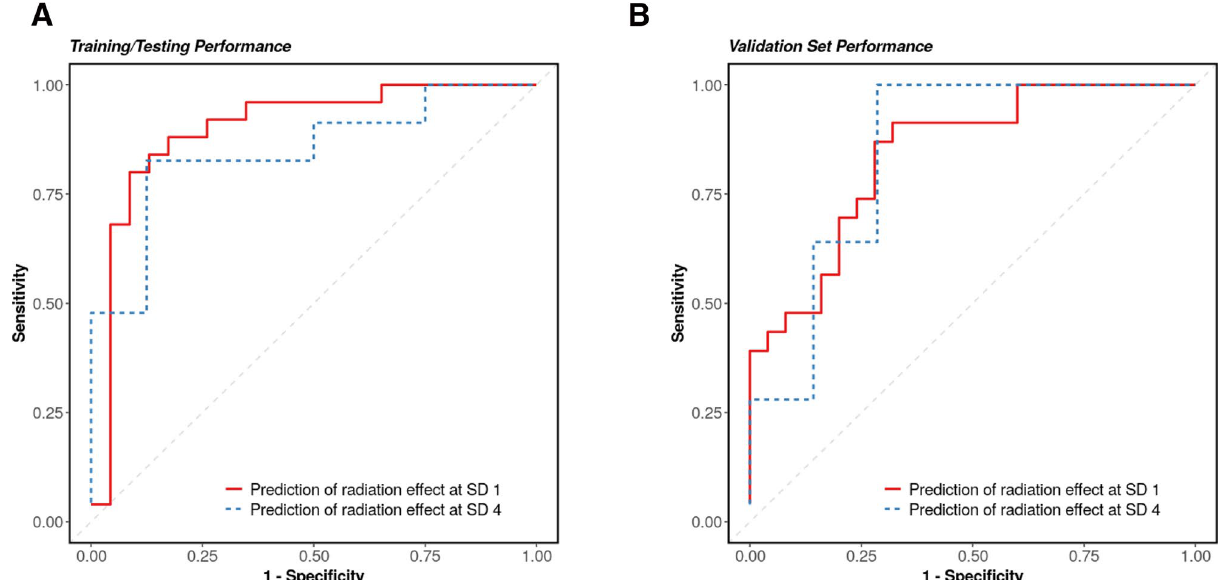
Figure 5. The biomarkers panel to distinguish whether NHP got radiation or not in SD 1 and SD 4. Four metabolites for SD 1 and SD 4 prediction: l-carnitine, PC(14:0/18:0), 2-thio PAF, 4-deoxyuridine. ( A ) training and testing performance yielded AUC = 0.899 for SD 1 model and AUC = 0.848 for SD 4 model. ( B ) validation performance with a AUC = 0.842 for SD 1 model and AUC = 0.846 for SD 4 model. Figure is created by